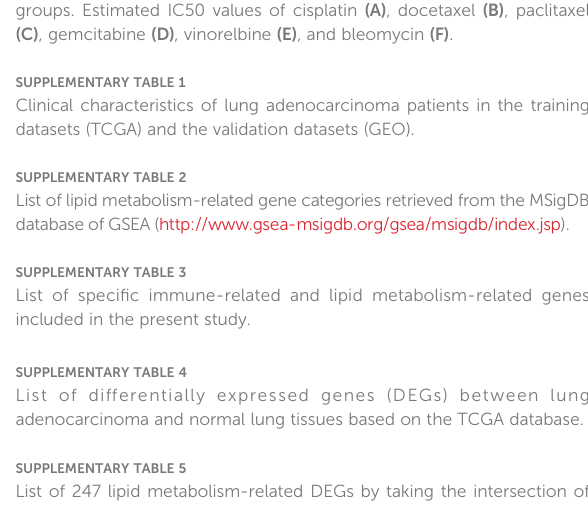
SUPPLEMENTARY TABLE 4 List of differentially expressed genes (DEGs) between lung adenocarcinoma and normal lung tissues based on the TCGA database. SUPPLEMENTARY TABLE 5 List of 247 lipid metabolism-related DEGs by taking the intersection of DEGs of LUAD and lipid metabolism-related